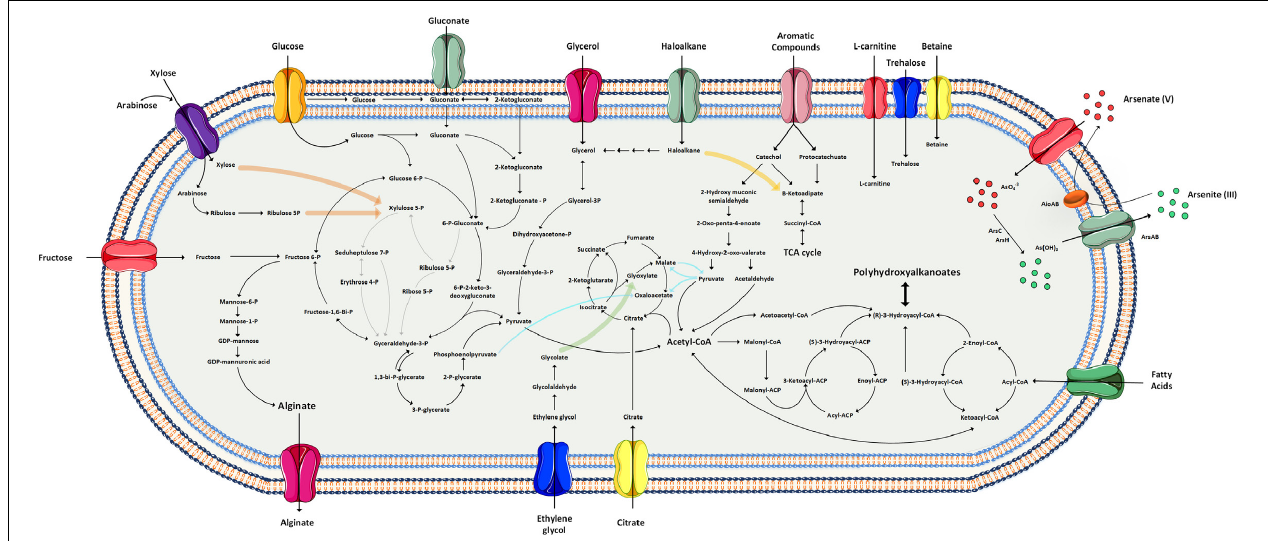
FIGURE 3 | Reconstruction of metabolic pathways of the Antarctic Pseudomonas sp. MPC6 based on genomic